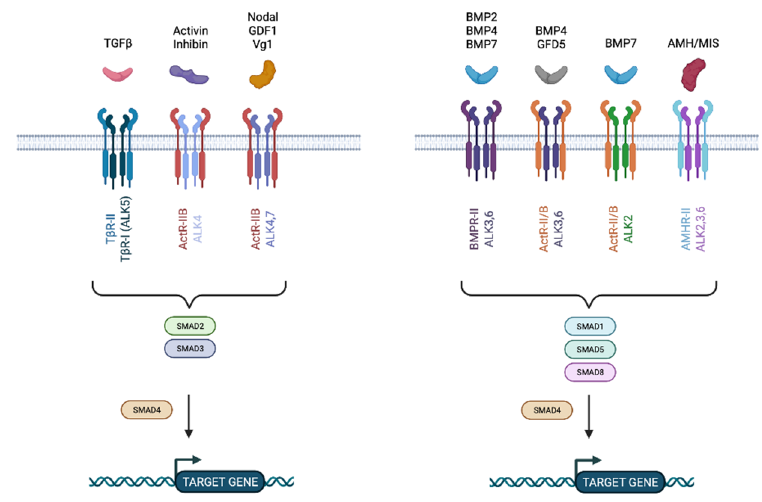
Figure 4. Schema of all the described TGF β ligands and Type I and II receptors. TGF β factors exert their effects through binding to specific cell surface receptors, classified into two subfamilies based on their structural and functional properties; Type I and Type II receptors. There are several Type I receptors; TGF β receptor (T β RI), activin receptor (ActR-IB), and two BMP receptors (BMPIR-IA and IB). The Type II receptor subfamily includes T β R-II, BMPR-II, and AMHR, which selectively bind TGF β , BMPs, and MIS, respectively (Figure 4). Those receptors are composed of a cysteine-rich extracellular domain allowing their ligands to bind, a transmembrane region, and a kinase domain, where the serine/threonine domain is found. Type II receptors typically contain a short C- terminal extension after the kinase domain which is absent in Type I receptors. In contrast, Type I receptors contain a characteristic extension GSGSG sequence, termed the GS domain. The activation of Type I receptors relies on the phosphorylation of its GS domain by the Type II receptors, generating a complex that phosphorylates and recruits downstream pathway effectors. In the case of TGF β , three different isoforms, TGF β 1, TGF β 2, and TGF β 3, exhibit similar properties. TGF β initiates signaling by binding to the Type II receptor which will permit the phosphorylation and recruitment of the Type I receptor, forming a heteromeric complex of Type I and II receptors. The signal will then propagate through phosphorylation of the SMAD proteins. There are eight different SMAD proteins, classified in three groups: (1) the receptor- regulated SMADs (R-SMAD), the co-mediator SMAD (Co-SMAD), and the inhibitory SMAD (I-SMAD). R-SMADs (SMAD 1, 2, 3, 5c and 8) are directly phosphorylated and activated by Type I receptor kinases and form heteromeric complexes with Co-SMAD (SMAD4) for further translocation into the nucleus to regulate the transcription of target genes (Figure 5). I-MADs, SMAD6 and SMAD7, negatively regulate TGF β signaling by competition with R-SMADs for receptor, Co-SMAD interaction or by targeting the receptors for degradation [58]. Once translocated into the nucleus, SMAD complexes recruit transcriptional coactivators, corepressors, and chromatin remodeling factors permitting the activation or repression of hundreds of target genes at once [59].